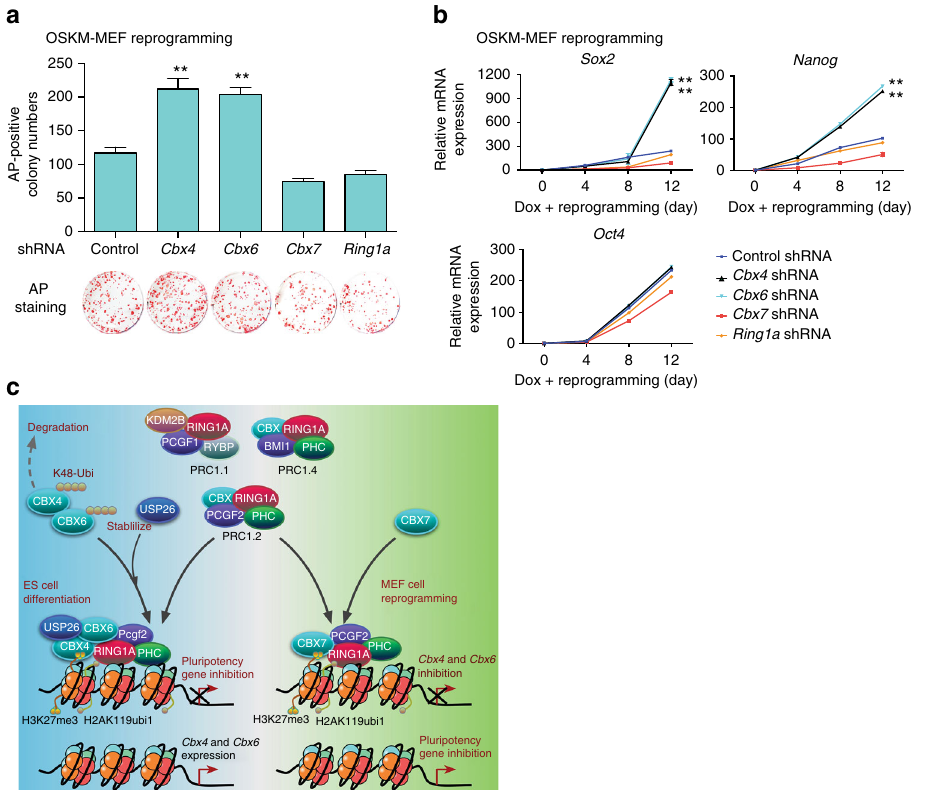
Fig. 7 Knockdown of CBX4 and CBX6 promotes MEF reprogramming. a AP staining of iPSC colonies after OSKM induction in MEF cells infected with Cbx4 , Cbx6 , Cbx7 , Ring1a , or control shRNA lentivirus, ** p < 0.01 compared to control shRNA. b Sox2 , Nanog , and Oct4 mRNA expression levels during MEF reprogramming with Cbx4 , Cbx6 , Cbx7 , Ring1a , or control shRNA lentivirus, ** p < 0.01 compared to control shRNA. c Proposed role of USP26 in